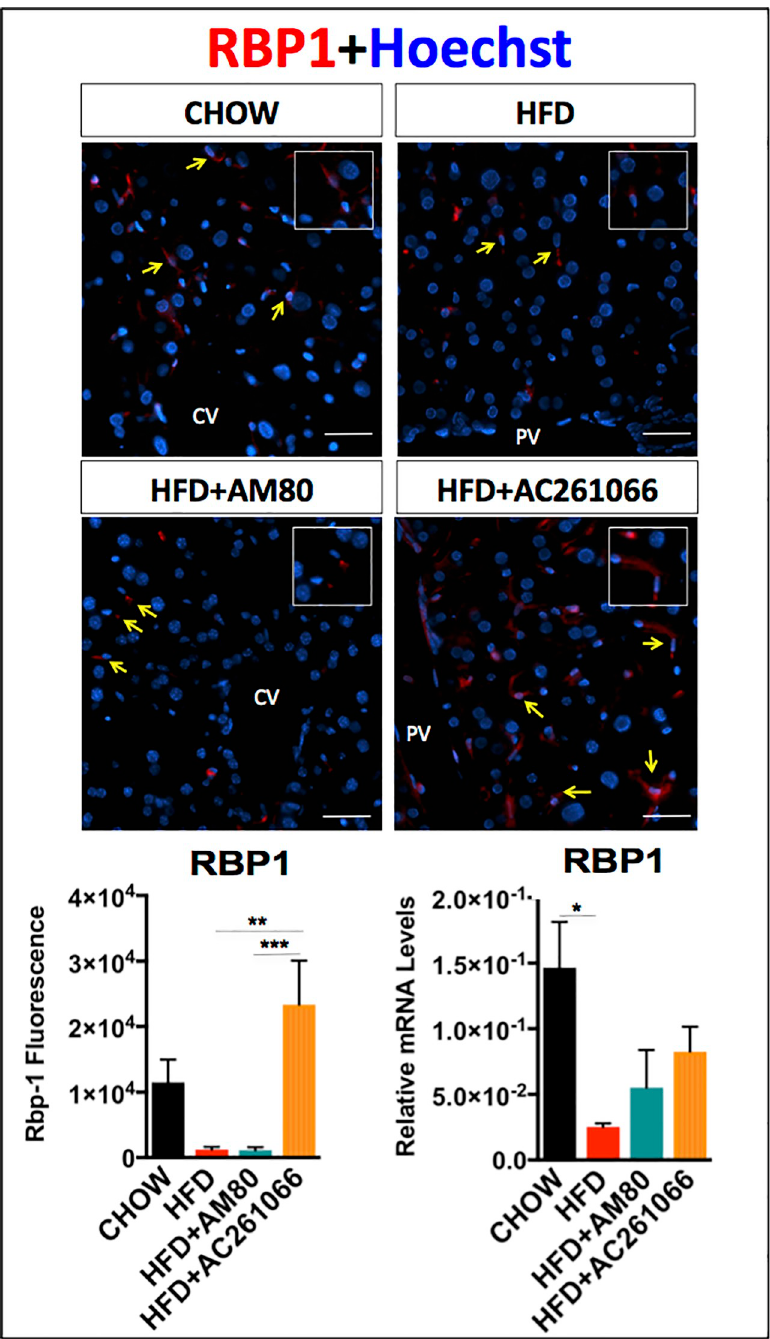
Fig 3. The RAR β 2 agonist AC261066 increases the hepatic levels of RBP1 in HFD-fed mice. Representative images depicting RBP1 in red and nuclei in blue (Hoechst labeling) assessed by immunofluorescence in frozen liver tissues and by qRT-PCR in chow-, HFD-, HFD+AM80-, and HFD+AC261066-treated mice. Yellow arrows in the images indicate representative areas of RBP1-positivity (inserts). Quantification of the immunofluorescence and mRNA levels is represented as a bar plot. The plots are represented as mean ± standard deviation (SD) (mice per group = 3–4; image fields per mouse > 4). Statistical significance is assessed by one-way ANOVA (black stars), p < 0.05 = � ; p < 0.01 = �� ; p < 0.001 = ��� . Magnification = 200X. Scale bar = 100 μ m. CV = central vein; PV = portal vein.